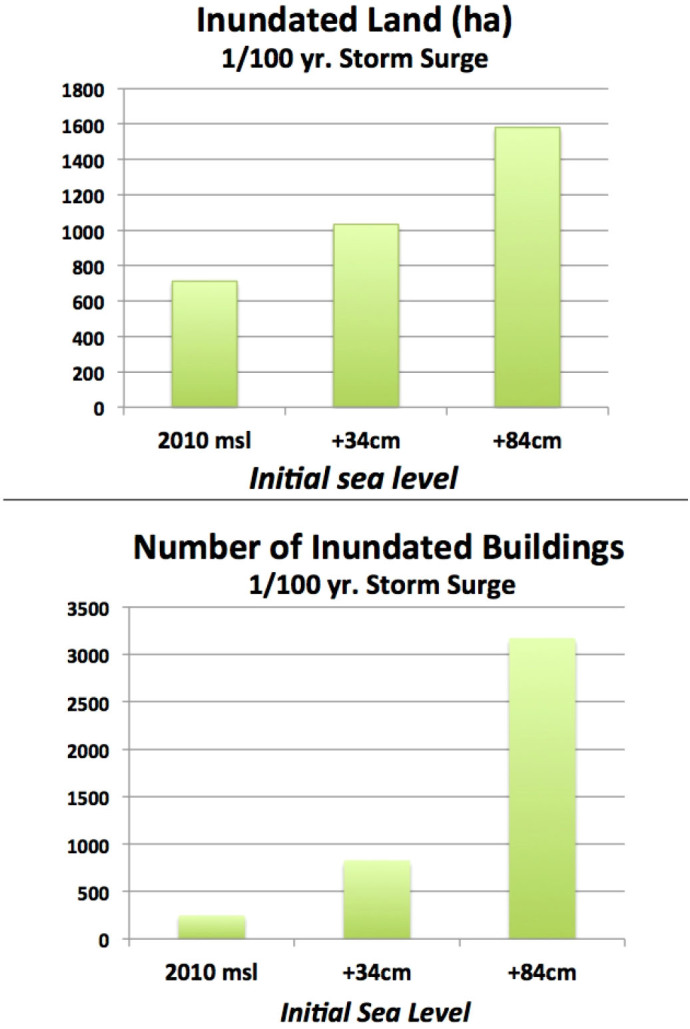
Storm surge exposure.(a) The land area inundated by the 1/100 yr. storm surge scenarios11 (b) Number of buildings inundated by the 1/100 yr. storm surge scenarios11.